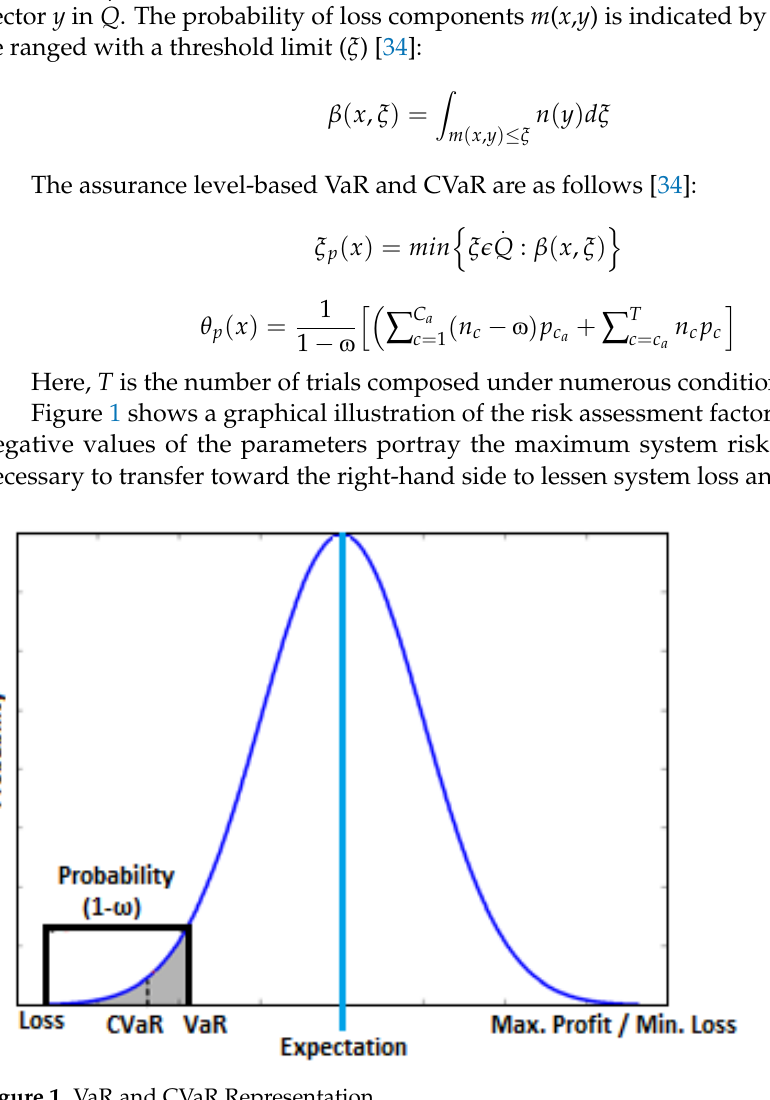
Figure 1. VaR and CVaR Representation.